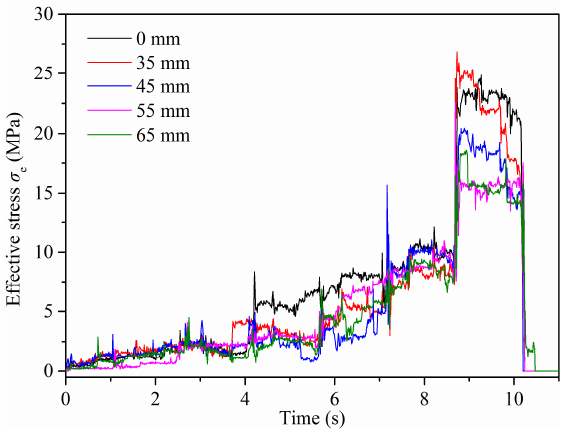
Figure 14. Effective stress of Element 3 in rocks with different hole diameters.